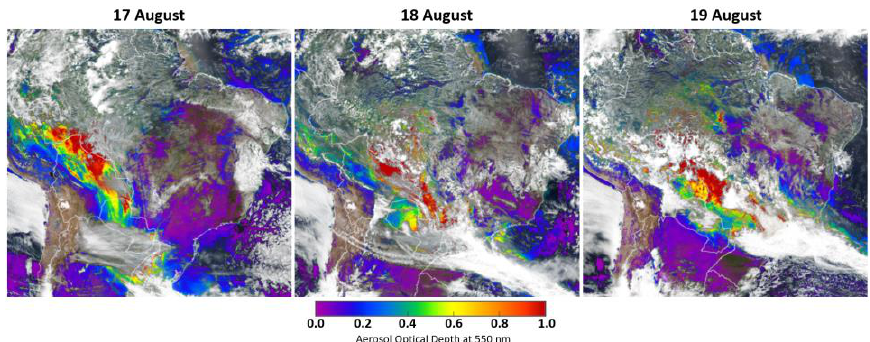
Figure 11. AOD map indicating BB plume over Brazil, Paraguay, Bolivia, and northern Argentina and Uruguay from 17 to 19 August 2019. AOD values were obtained from the VIIRS on Suomi NPP satellite data.